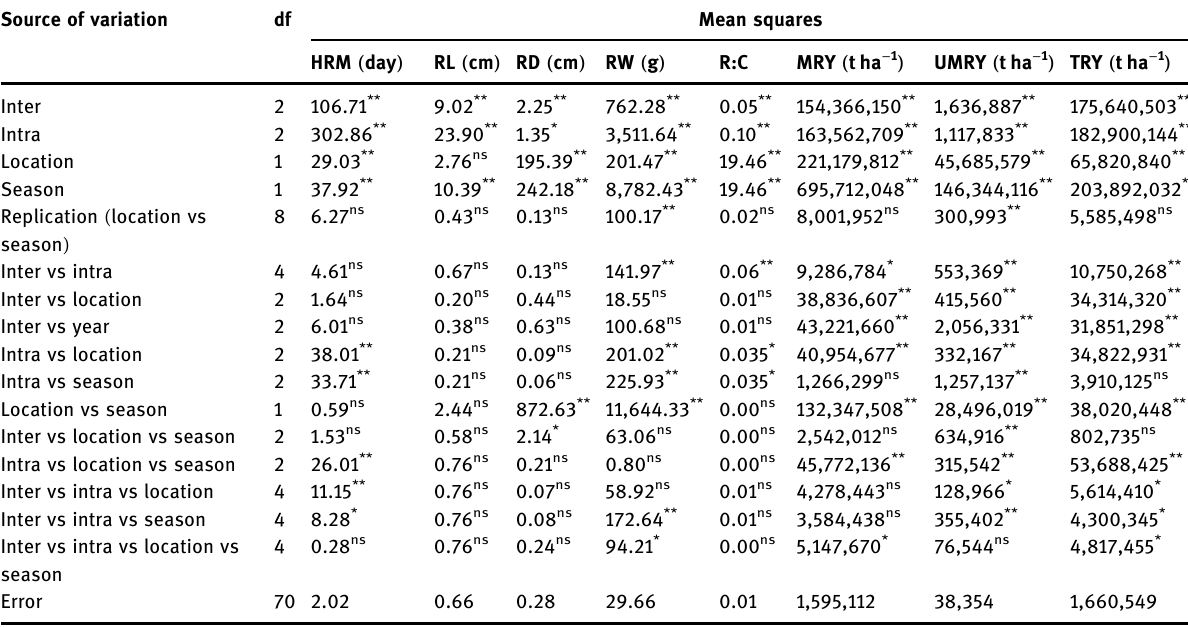
Table 1: Combined ANOVA mean squares of treatments ’ e ff ects on yield, yield components, and days to maturity of carrot over years and locations Source of variation df Mean